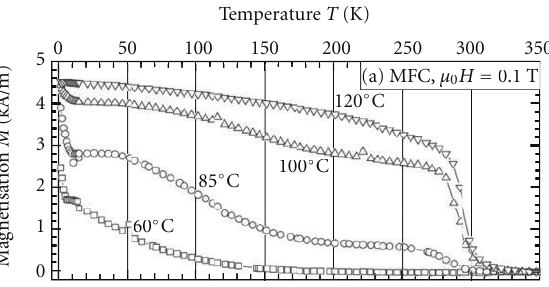
Figure 9: Temperature-dependent magnetisation of samples fabricated with substrate temperatures T S between 60 and 120 ◦ C. Reproduced from [15]. Copyright ©2006, The American Physical Society.